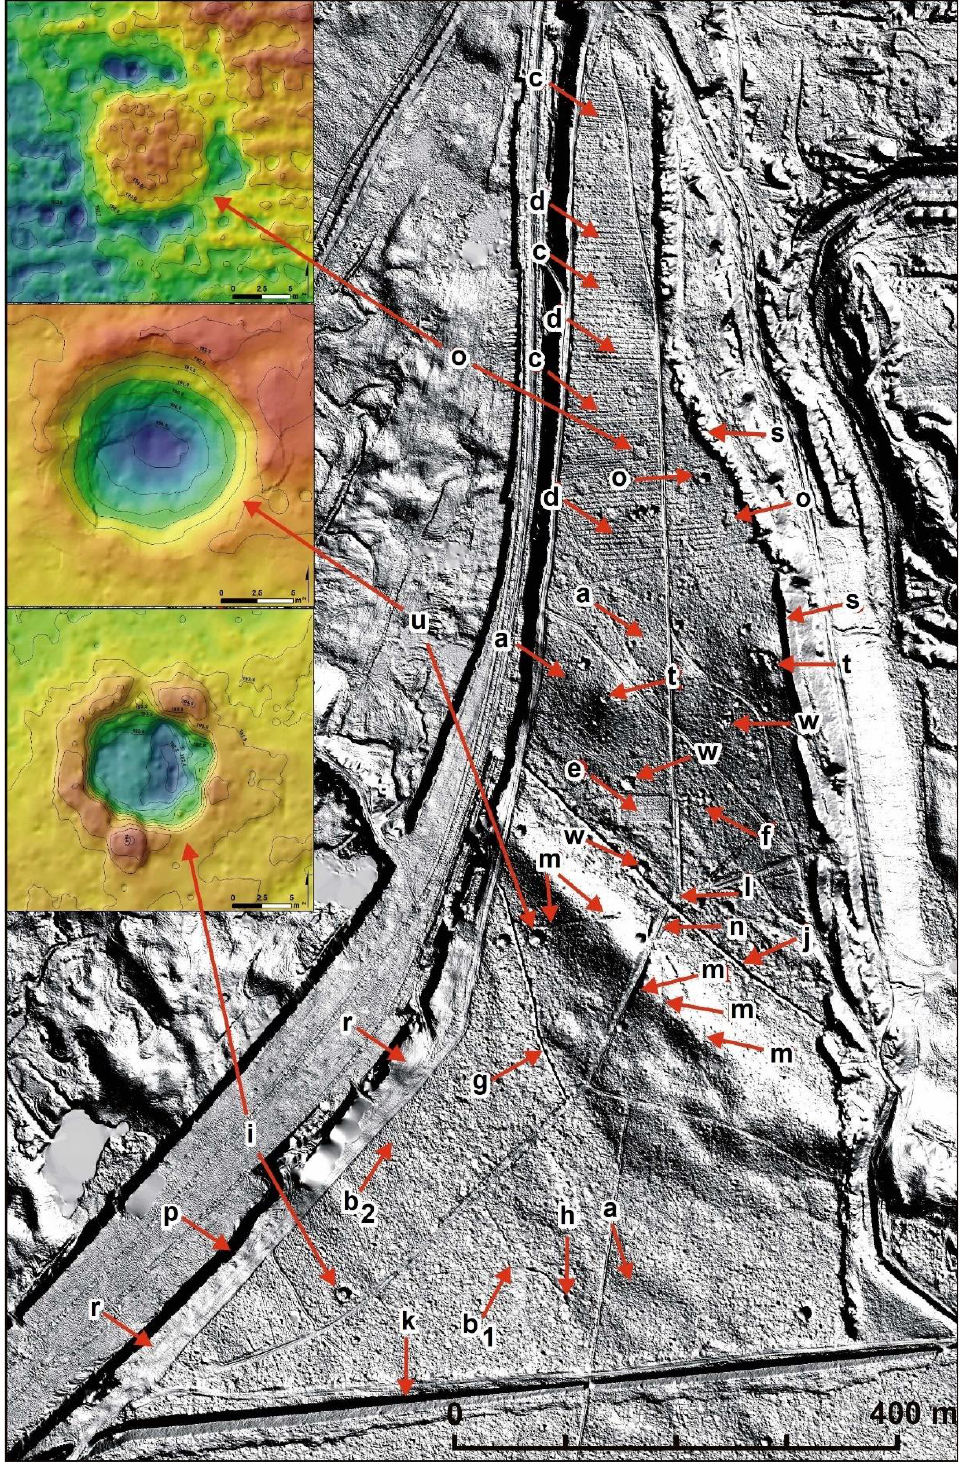
Figure 2. Study area: ( a ) forest area cultivated using the traditional no-till method around 100 years ago; ( b ) traces of shallow forest tillage from ( b1 ) 80 and ( b2 ) 55 years ago; ( c ) traces of deep tillage from 30 years ago; ( d ) traces of deep tillage from 30 years ago—deeper furrows breaking the